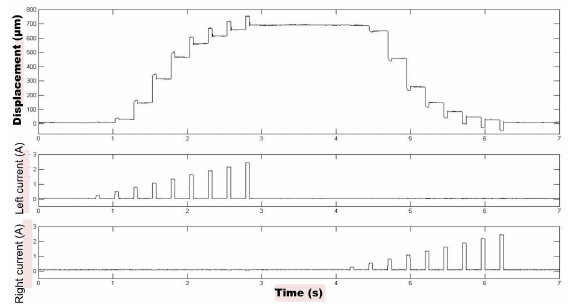
Figure 8: Current pulses control of the MSMA-based actu- ator.